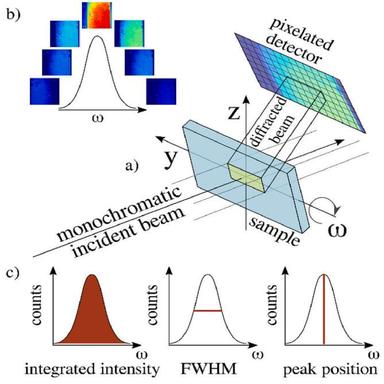
RCI technique: (a) the sample is in Bragg position for a chosen reflection; the diffracted intensity is recorded by a pixelated detector (b) a series of images (~200) is recorded for different angular positions along the rocking curve (c) RCI maps generated from the rocking curves recorded on each of the pixels of the detector show the variation across the crystal of the integrated intensity, peak width (FWHM) and peak position.